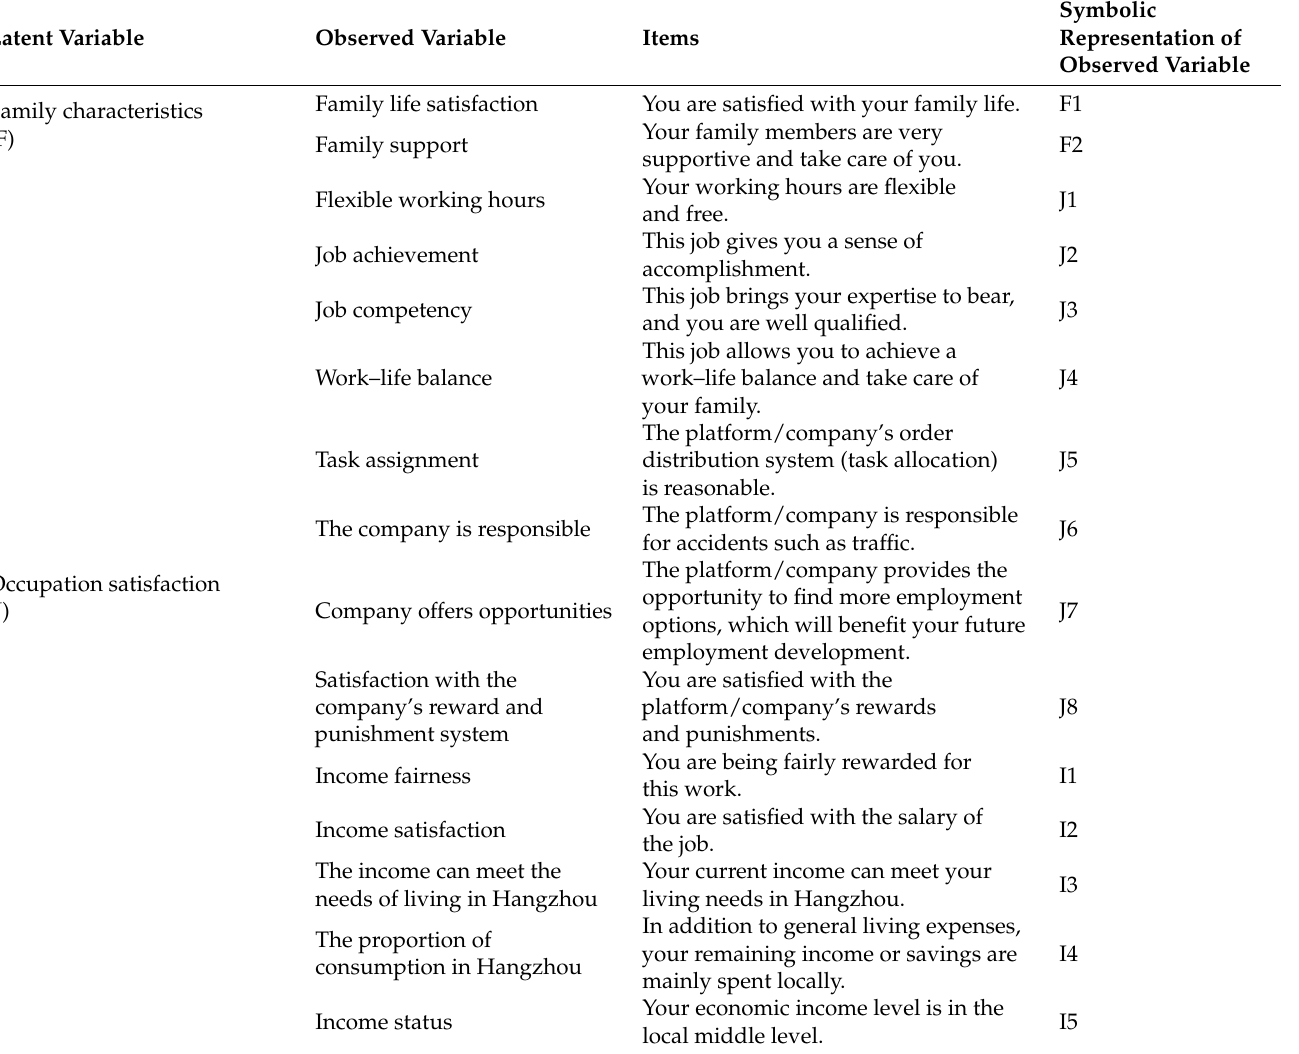
Table 2. Measurement of